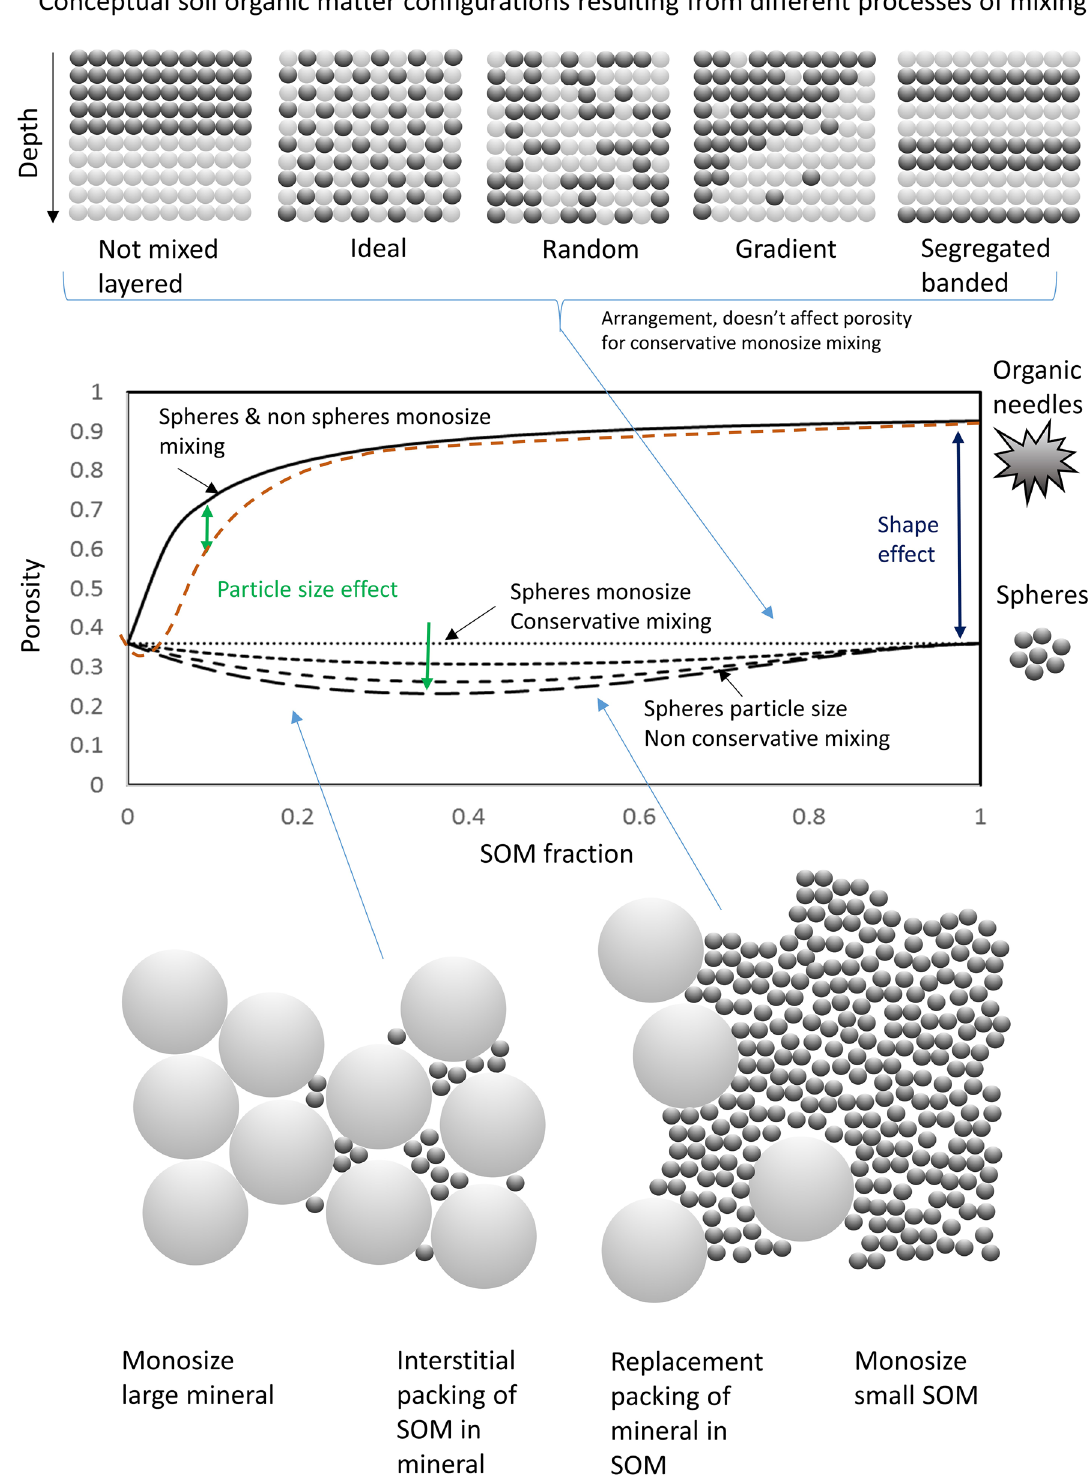
Figure 2. A conceptual diagram illustrating the expected response of porosity to different forms of mixing of mineral and organic matter accounting for the effects of particle shape and size distribution. The solid black line represents Eq. S18. Particle size distribution for mono-size spheres, then increasingly small spheres packed in large are shown by the dashed lines (size ratios = 0, 2.5. 5, 10), using the equations in Ref. 51 . The particles on the right side of the graph indicate the change from spherical particles to very non-spherical fibrous particles, the shape effect. The dashed orange line indicates our anticipated effect of particle size in combination with shape. Figure created by first author using Microsoft PowerPoint Version 16.0.4266.1001. https:// www. micro soft. com/ en- us/ micro soft- 365/ power